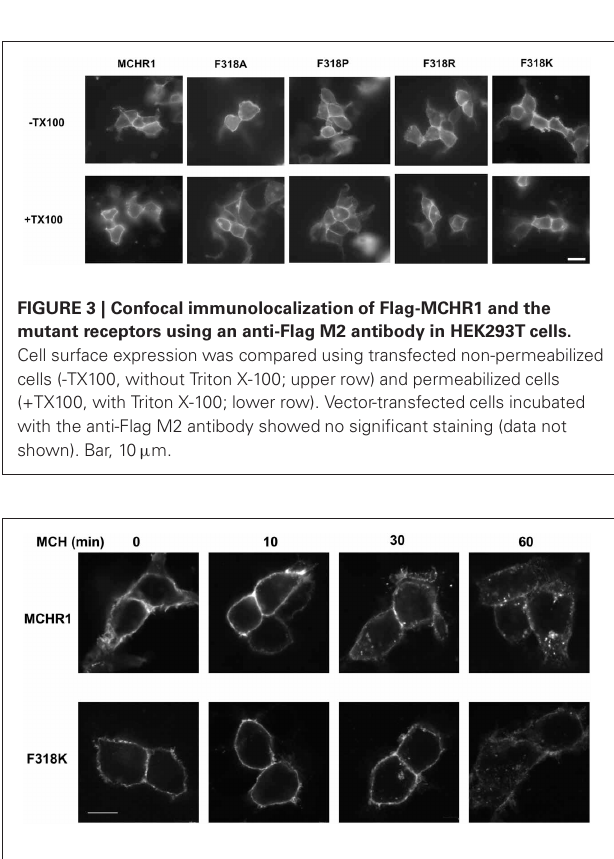
FIGURE 4 | MCH-mediated receptor internalization in HEK293T cells. Cells expressing MCHR1 or the F318K mutant were stimulated with 1 μ M MCH for the time shown, fixed and imaged by confocal fluorescence microscopy. Prior to MCH addition, cells were incubated with serum-free DMEM for 3h. Bar, 10 μ